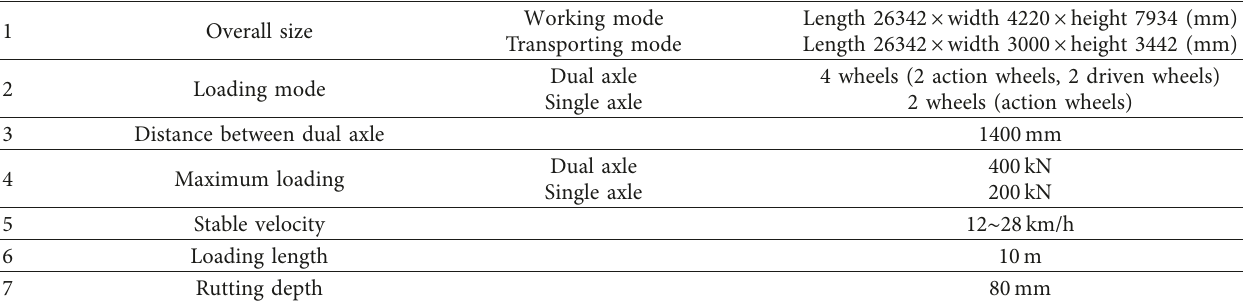
Table 5: The main technical parameters.